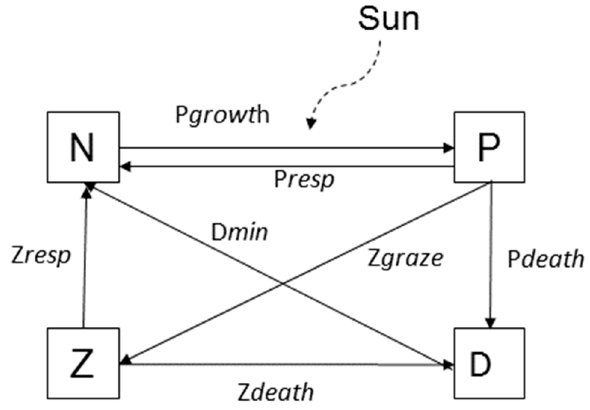
Figure 3. Schematic NPZD model. State variables N (nutrients), P (phytoplankton), Z (zooplankton), and D (detritus) and the various processes affecting them.